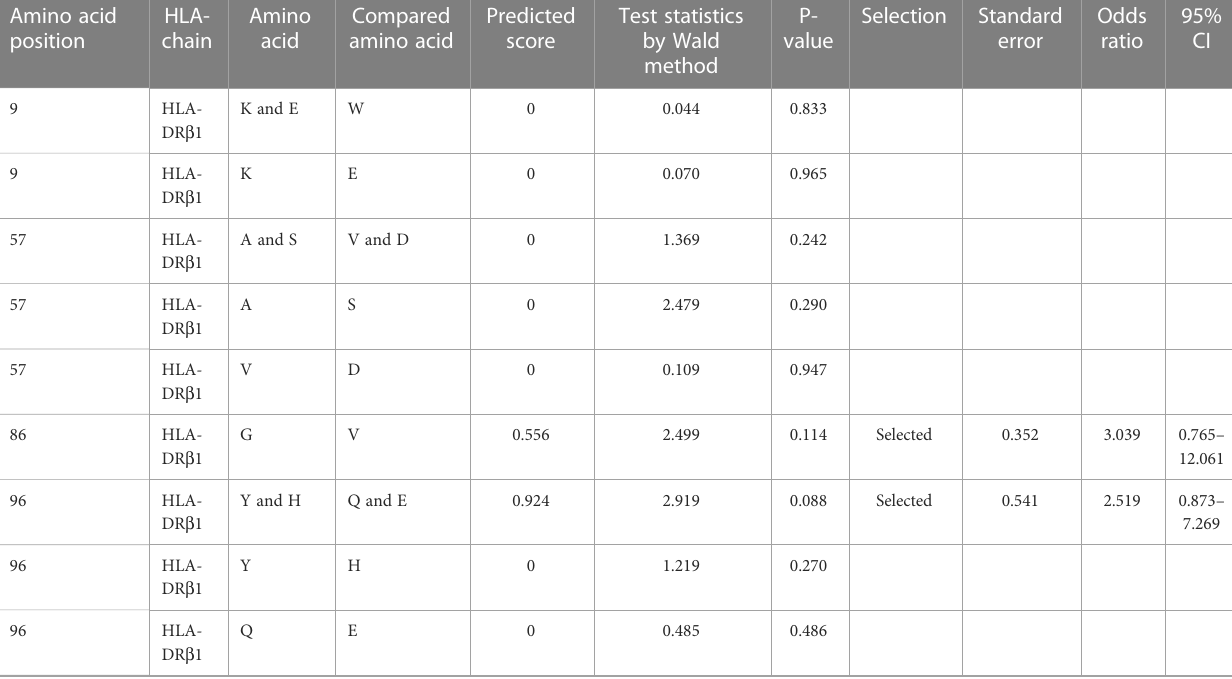
TABLE 3 Stepwise selection and multivariate regression analysis of amino acid polymorphisms across HLA-class II alleles in ICI-T1DM patients and ICI-controls. Amino